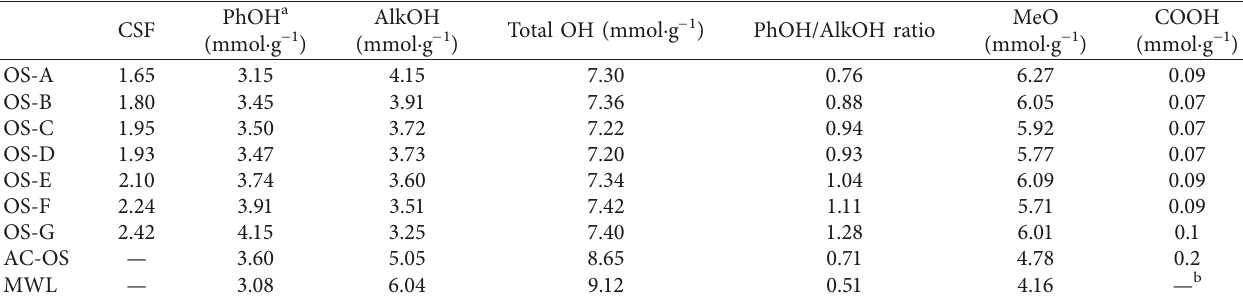
Table 4: Functional group content of the larch organosolv samples. PhOH-, AlkOH-, and MeO contents were determined via 1 H NMR and COOH content via 31 P